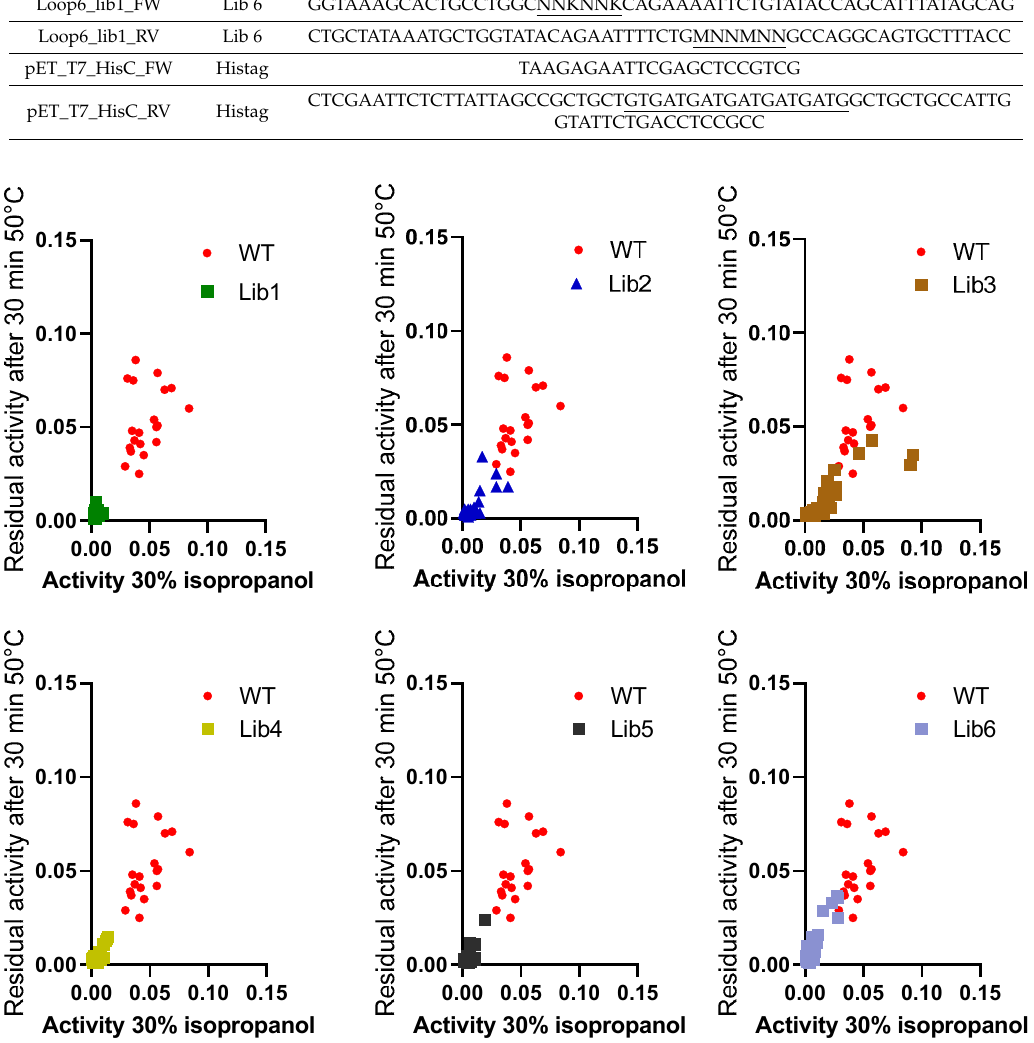
Figure A1. Variants from all libraries that were picked into microtiter plates ( ≈ 1700 clones) were screened for thermal resistance (52 ◦ C for 30 min) and for p NPB esterolytic activity in the presence 30% isopropanol. No variants were identified with increased thermal resistance, and only variant P5F3 (F41L- ∆ W42- ∆ D43-K44P) was recovered from screening towards increased activity in the presence of isopropanol.